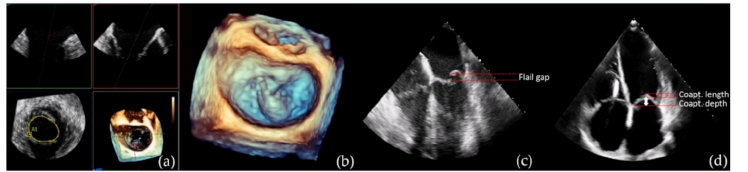
Figure 2. Showing some examples of echocardiographic imaging modalities commonly used for Mi- traClip suitability evaluation. From left to right: ( a ) 3D Xplane mitral valve area (MVA) measurement; ( b ) 3D en face view showing a P2 flail and chordal rupture; ( c ) Transesophageal echocardiogra- phy (TEE) four chamber view for flail gap evaluation; ( d ) transthoracic echocardiogram (TTE) four chamber view screening of coaptation depth and length in secondary